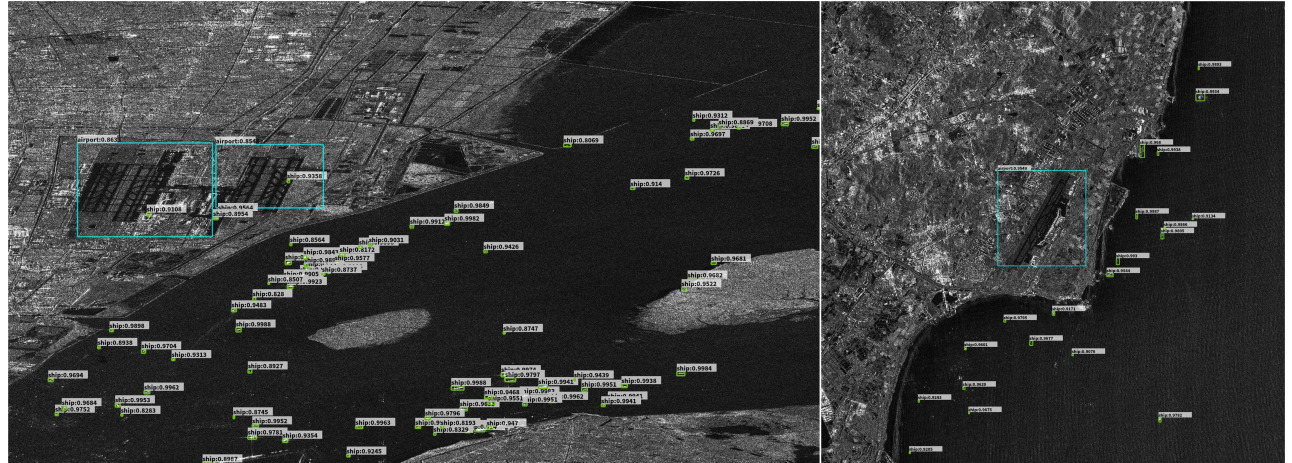
Figure 14. The algorithm proposed in this paper detects large SAR images. There are two kinds of targets with huge scale differences in the two ultra-large SAR images tested, which are a small ship target and an ultra-large airport